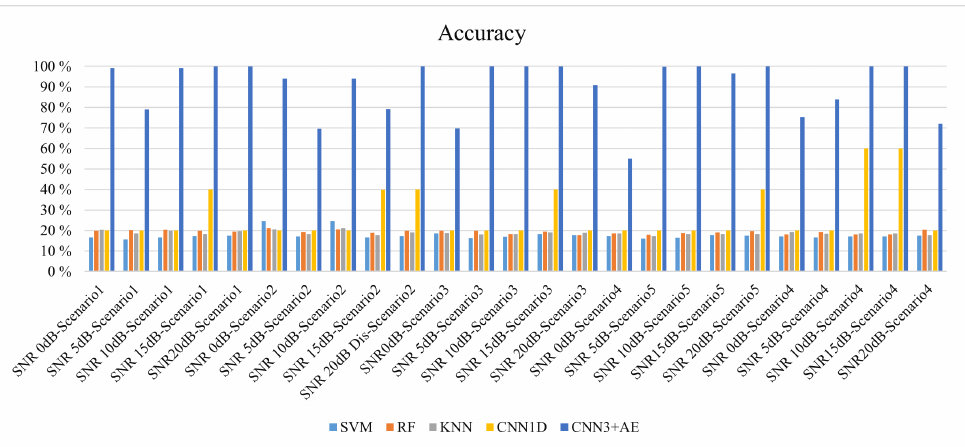
Figure 9. The overall accuracy for the traditional ML vs. the proposed approach across a range of channel scenarios and SNR